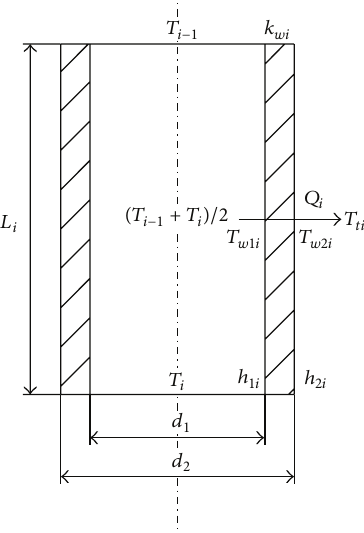
Figure 3: Calculation model diagram of the 𝑖 ’th